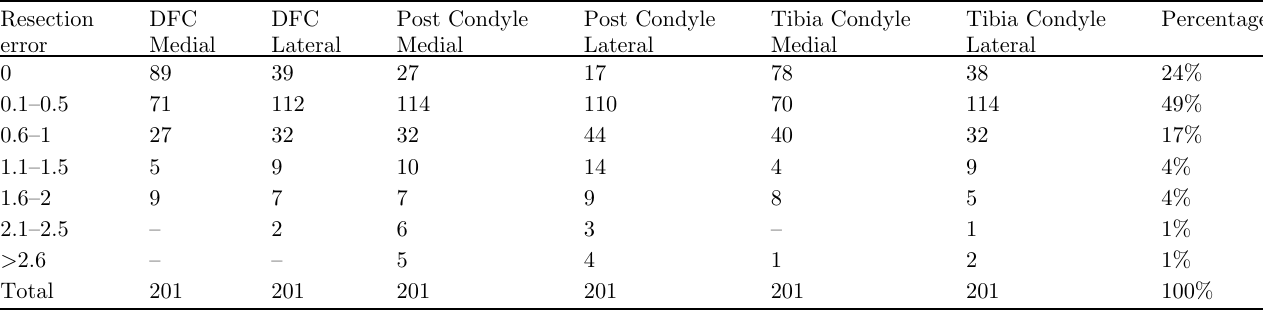
Table 2. Resection errors in each of the Six Bone Cuts. The table represents the range of resection errors recorded starting from no error to more than 2.6mm, in each of the different bone resections recorded, namely Distal Femur Medial Condyle, Distal Femur Lateral Condyle, Posterior Condyle Medial, Posterior Condyle Lateral, Tibial Medial Condyle, Tibial Lateral